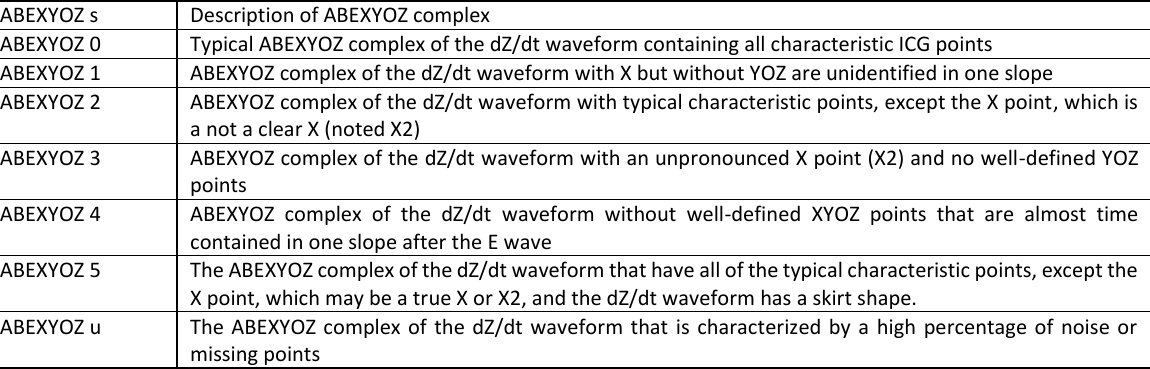
Table 6. Characteristic pattern of ABEXYOZ